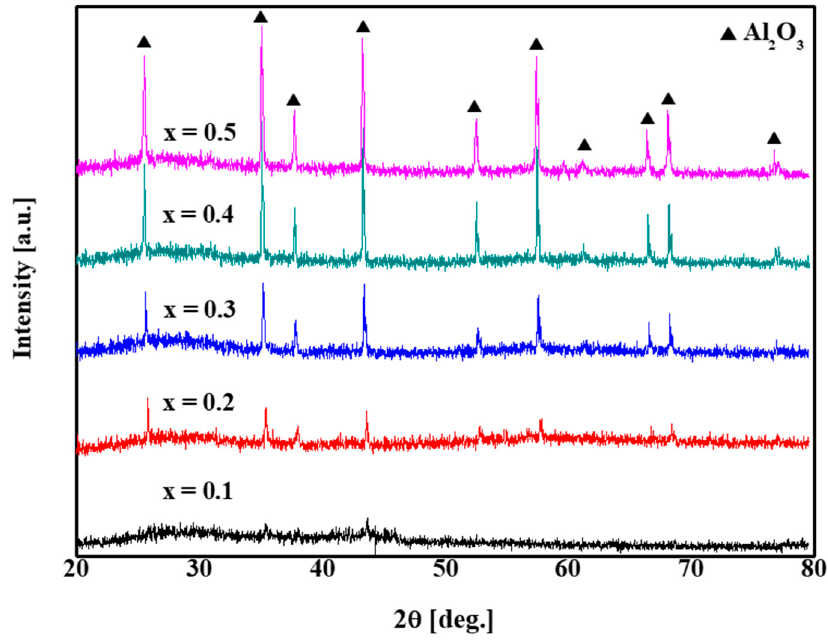
Figure 9. X-ray di ff raction (XRD) results of [xglass / (1 − x)Al 2 O 3 )] composite samples for Figure 9. X-ray diffraction (XRD) results of [xglass/(1 − x)Al 2 O 3 )] composite samples for x = 0.1 − 0.5 Al 2 O 3 x = 0.1 − 0.5 Al 2 O 3 .